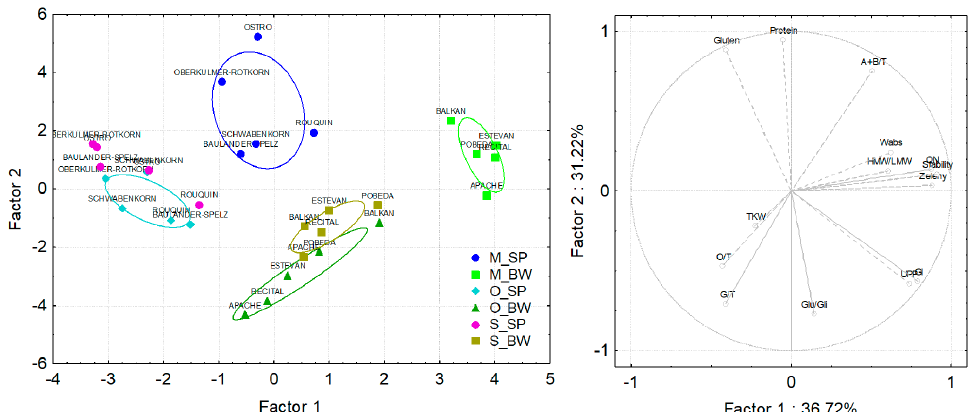
Figure 5. Principal component analysis of spelt and bread wheat varieties based on all analyzed compositional and func ‐ tional quality traits. M—conventional growing site in Martonvásár, Hungary, O—organic growing site in Hungary, S— conventional growing site in Serbia. SP—spelt wheat, BW—bread wheat. GI—gluten index, Wabs—water absorption, Stability—dough stability time, QN—farinograph quality number, Zeleny—Zeleny sedimentation volume, TKW—thousand-kernel weight, Glu/Gli—the quantitative ratio of glutenins to gliadins, UPP—unextractable polymeric proteins, HMW/LMW—the quantitative ratio of high molecular weight and low molecular weight glutenin subunits, A+B/T—the portion of alfa and beta gliadins in total gliadins, G/T—the portion of gamma gliadins in total gliadins, O/T—the portion of omega gliadins in total gliadins.